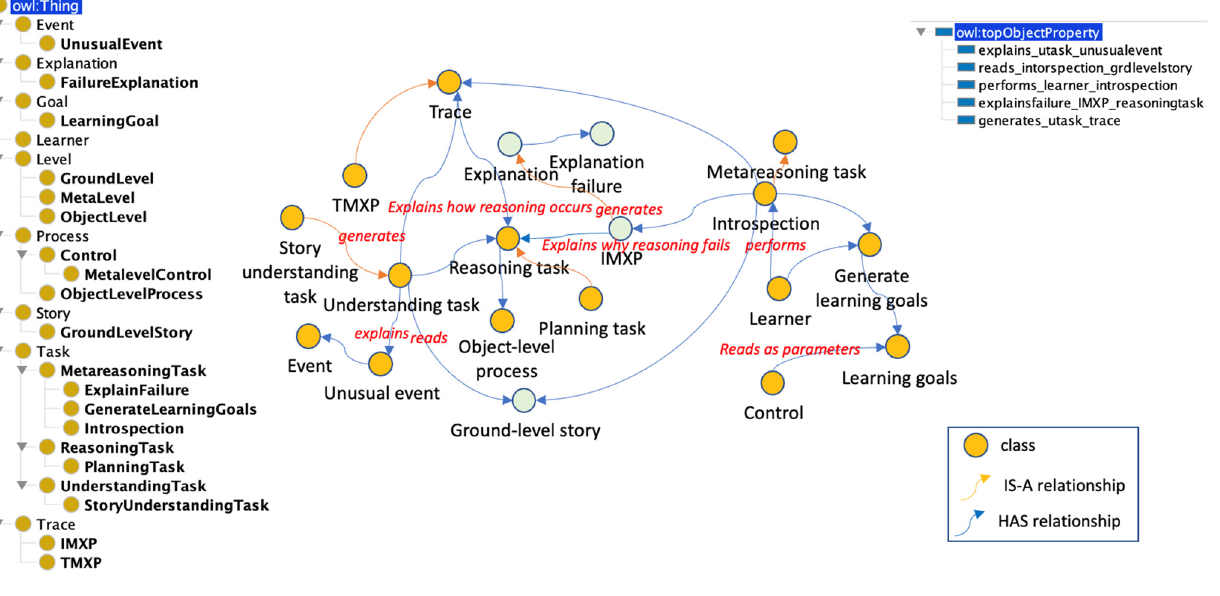
Figure 12. The SE&SUP